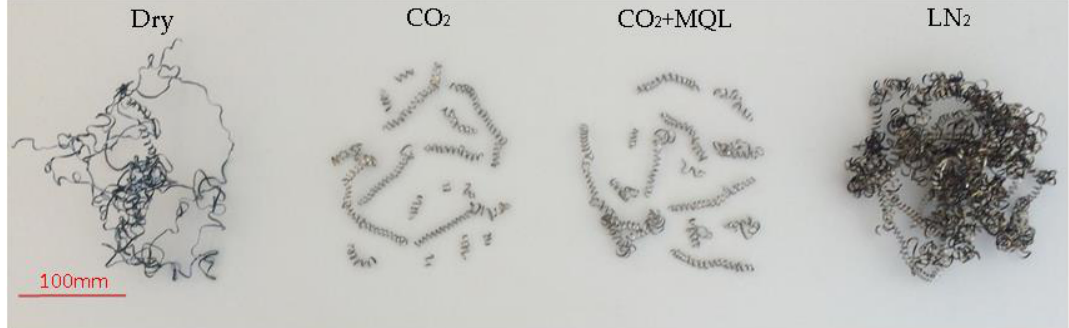
Figure 11. Images of generated chips under dry, carbon dioxide (CO 2 ), CO2+MQL, and liquid nitrogen (LN 2 )-assisted machining conditions.